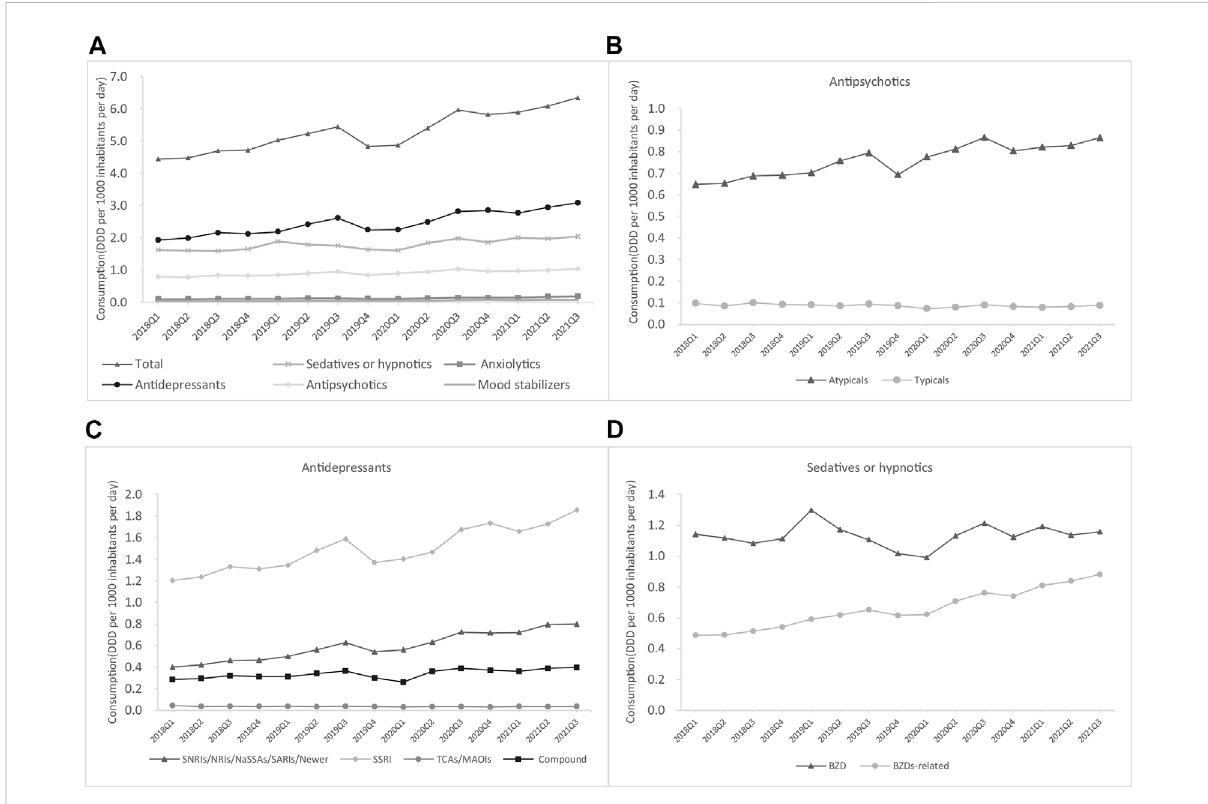
FIGURE 1 TrendsinpsychotropicutilizationforeachclassinChina ’ shospitals (A) Overall (B) Antipsychotics (C) Antidepressants (D)